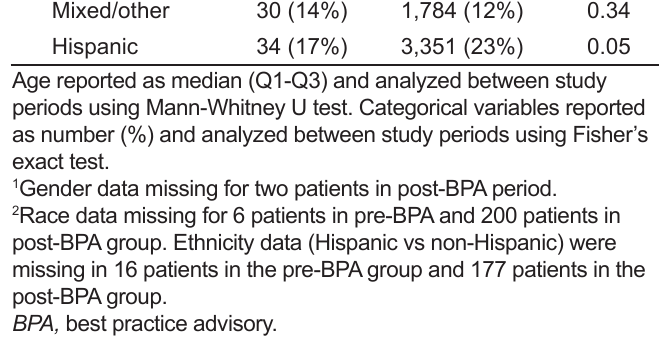
Age reported as median (Q1-Q3) and analyzed between study periods using Mann-Whitney U test. Categorical variables reported as number (%) and analyzed between study periods using Fisher’s exact test. 1 Gender data missing for two patients in post-BPA